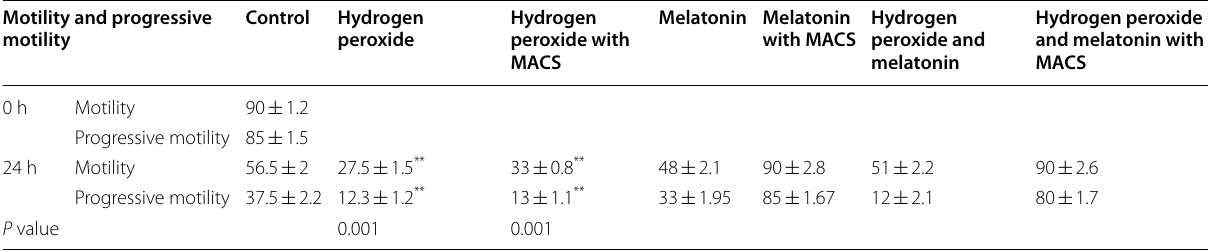
Table 2 The percentages mean of sperm motility and progressive motility in 0 h and 24 h within the whole sample with or without MACS Motility and progressive motility Values are expressed as mean SD. P values < .05 was considered statistically significant ± ** p 0.001 (Comparison with the control group in the 24-h group) ≤